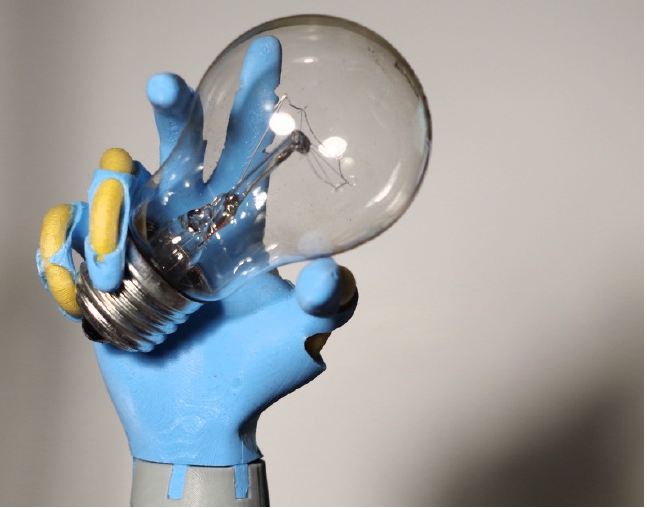
Figure 2. A soft robotic hand with a simple binary controller is naturally able to adapt, when handling delicate objects [22] .